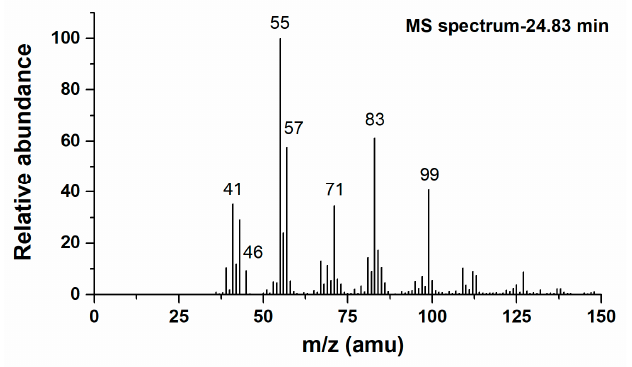
Figure 4. Mass spectra corresponding to the chromatographic peak at 24.83 min.